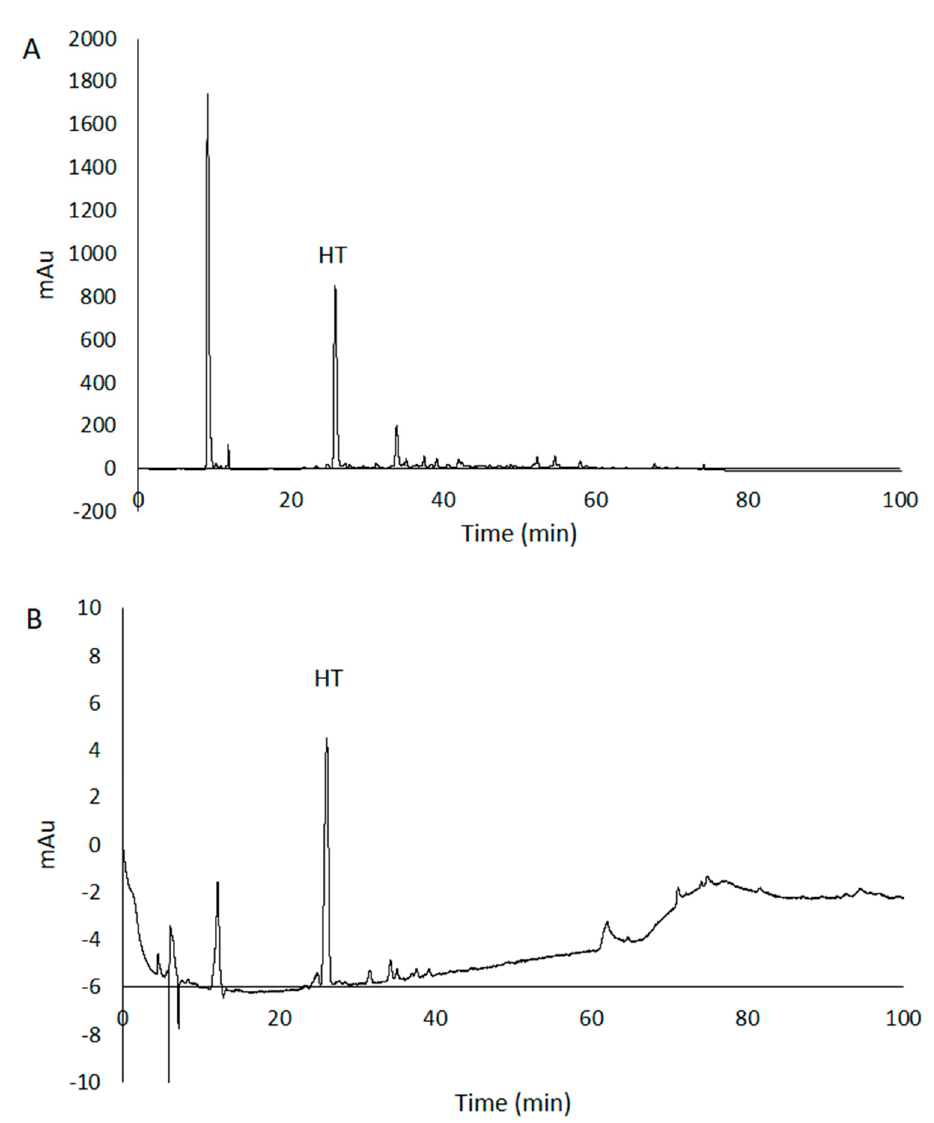
Figure 2. Chromatographic profile of OOD raw extract ( A ) and HT − enriched pool ( B ). HT − enriched pool was prepared by means of XAD7HP resin according to Method 3, as described in Section 2.3. HT: hydroxytyrosol.